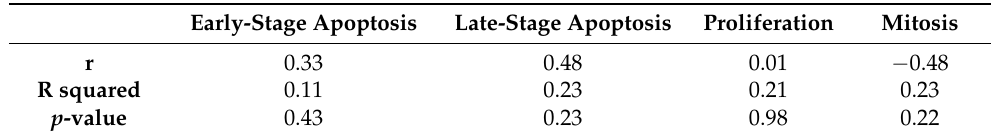
Table 1. Pearson correlation coefficient (r), R squared and p for the total FITC-avidin uptake versus each of the colocalised datasets shown in Figure 5E.